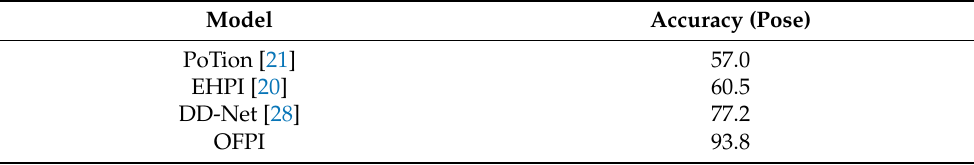
Table 6. Average classification accuracy of the JHMDB dataset compared to other purely pose-based